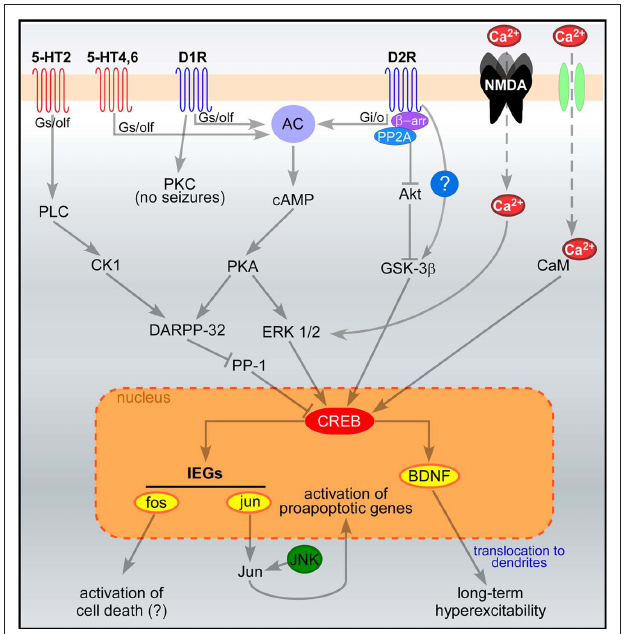
FiguRE 1 | Signaling pathways acutely activated in hippocampal neurons following seizures. Pathways downstream of glutamate, serotonin and dopamine receptors are illustrated. Seizures induce massive influx of Ca 2 + through NMDA receptors and voltage-gated Ca 2 + channels (in green), leading to CREB phosphorylation via ERK and calmodulin-dependent signaling, respectively (West et al., 2002). Serotonin and dopamine signaling modulate seizure-induced CREB phosphorylation via the activation of DARPP-32 and ERK1/2. Once phosphorylated, CREB promotes the transcription of activity-dependent genes such as BDNF and the IEGs fos and jun . The sustained induction of jun has been shown to switch on apoptotic cascades, whereas the pro-apoptotic role of fos induction has been questioned. Dendritic localization of BDNF mRNA and protein may also contribute to long-term excitability. The proposed scheme is a general (though not complete) summary of the intracellular pathways induced by seizures in the hippocampus. All the reported serotonin and dopamine receptor subtypes are expressed in the hippocampus, together with their signaling proteins (Meador-Woodruff et al., 1991; Perez and Lewis, 1992; Hannon and Hoyer, 2008). However, important differences may occur in different types of hippocampal neurons (e.g., dentate granule cells, pyramidal neurons), due to the different expression levels of these proteins. Abbreviations: AC, adenylate cyclase; CaM, calmodulin; CK1, casein kinase 1; DARPP-32, dopamine and cAMP-regulated phosphoprotein of 32 kDa; D1R and D2R, dopamine receptors (D1 and D2 subtypes); ERK, extracellular-regulated kinase; GSK-3 β , glycogen synthase kinase 3 β ; IEGs, immediate early genes; JNK, Jun-terminal kinase; NMDA, NMDA glutamate receptors; PKA, protein kinase A; PKC, protein kinase C; PLC, phospholipase C; PP-1, protein phosphatase 1; 5-HT, serotonin receptors. Question marks indicate that some pathways have been proposed but not